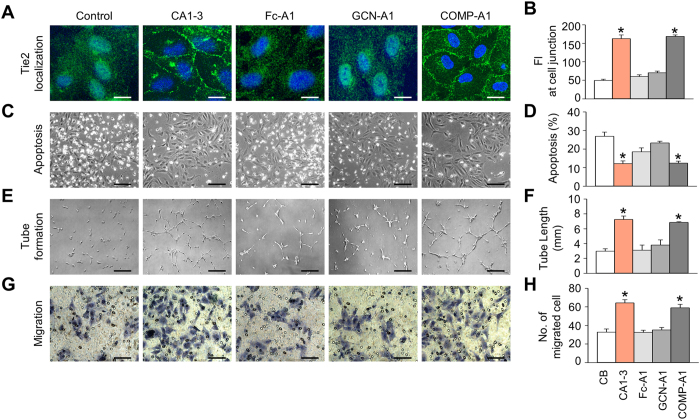
Biological effects of dimeric CMP-Ang1 in HUVECs.(A,B) Confluent HUVECs were starved in serum-free medium and stimulated with either control buffer (CB), 500 ng/ml of CA1-1, CA1-2, CA1-3, GCN-Ang1, FC-Ang1, or COMP-Ang1 for 15 min. (A) Images of HUVECs stained for Tie2 (green) and nucleus (blue). Scale bars, 10 μm. (B) Quantification of the fluorescence intensity (FI) of Tie2 at cell junction. (C,D) HUVECs were incubated with serum-free medium containing CB or 500 ng/ml of Ang1 variants. (C) Phase-contrast photographs were taken at 48 hr after serum starvation. Scale bars, 100 μm. (D) Apoptotic cells were measured by TUNEL immunostaining and flow cytometry. (E,F) HUVECs were plated on MatrigelTM coated wells and were incubated with serum-free medium stimulated with CB or 500 ng/ml of Ang1 variants. (E) Phase-contrast photographs were taken at 7 hr after treatment. Scale bars, 100 μm. (F) Tube formation activities were measured by total tube length. (G,H) Migration activity assay was performed using a modified Boyden chamber assay. HUVECs were seeded in the upper layer of 8 μm-pore membrane. Serum-free medium containing 500 ng/ml of Ang1 variants was added in the bottom of the chamber. (G) The migrated cells were fixed and stained after 9 hr incubation. Scale bars, 100 μm. (H) The migrated cells on the bottom of membrane were counted. Each graph indicates the mean ± SD of three experiments. *p < 0.05 versus CB.